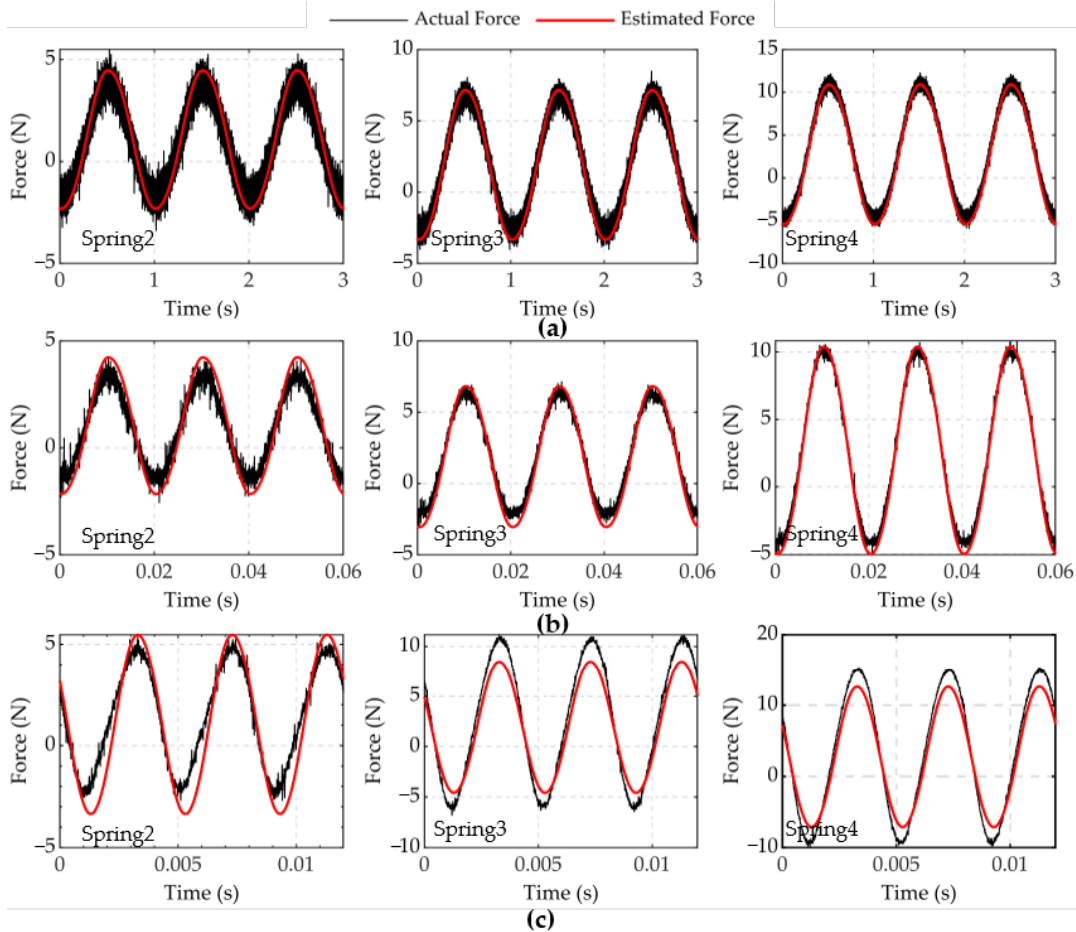
Figure 16. Comparison between the actual dynamic force and the estimated force at different frequencies: ( a ) 1; ( b ) 50; ( c ) 250 Hz.